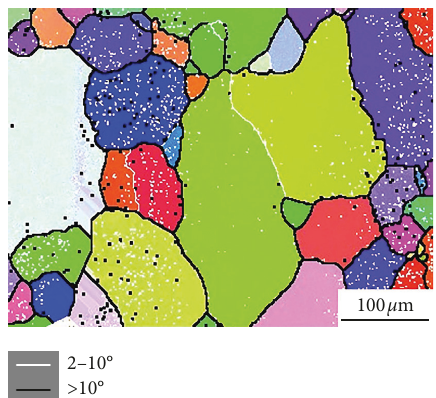
Figure 5: Orientation map of the annealed sample.